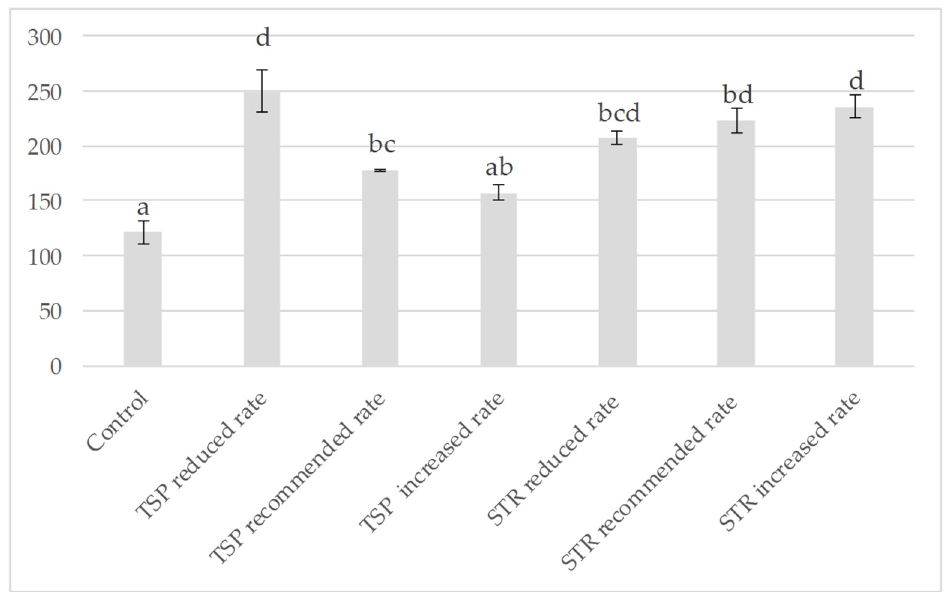
Figure 1. Phosphorus content in butterhead lettuce leaves (mg kg − 1 DM) as affected by interaction of examined factors (A × B) at the level of significance α = 0.05 ( p value <